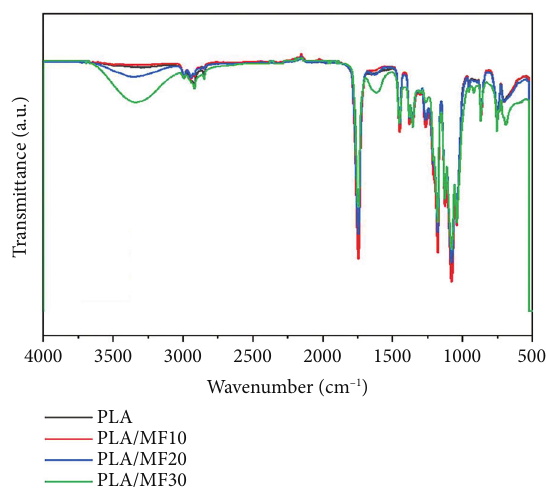
Figure 10: IR spectra of PLA/MF